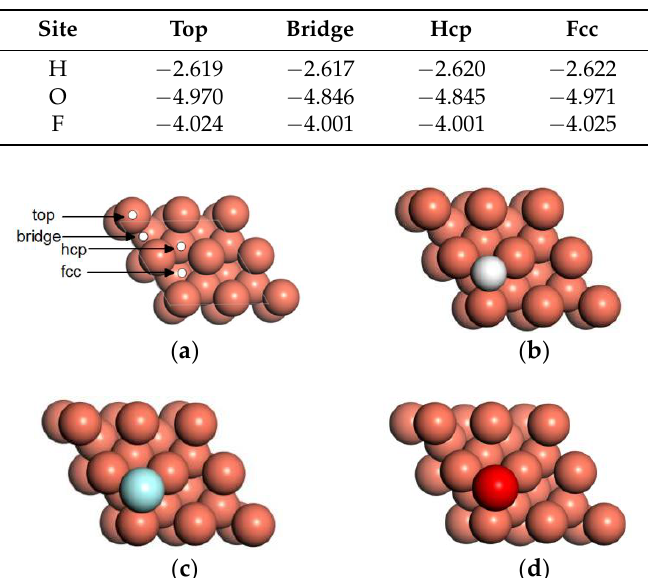
Table 3. Adsorption energies of H, F, and O atoms on Cu(111) surface (eV).